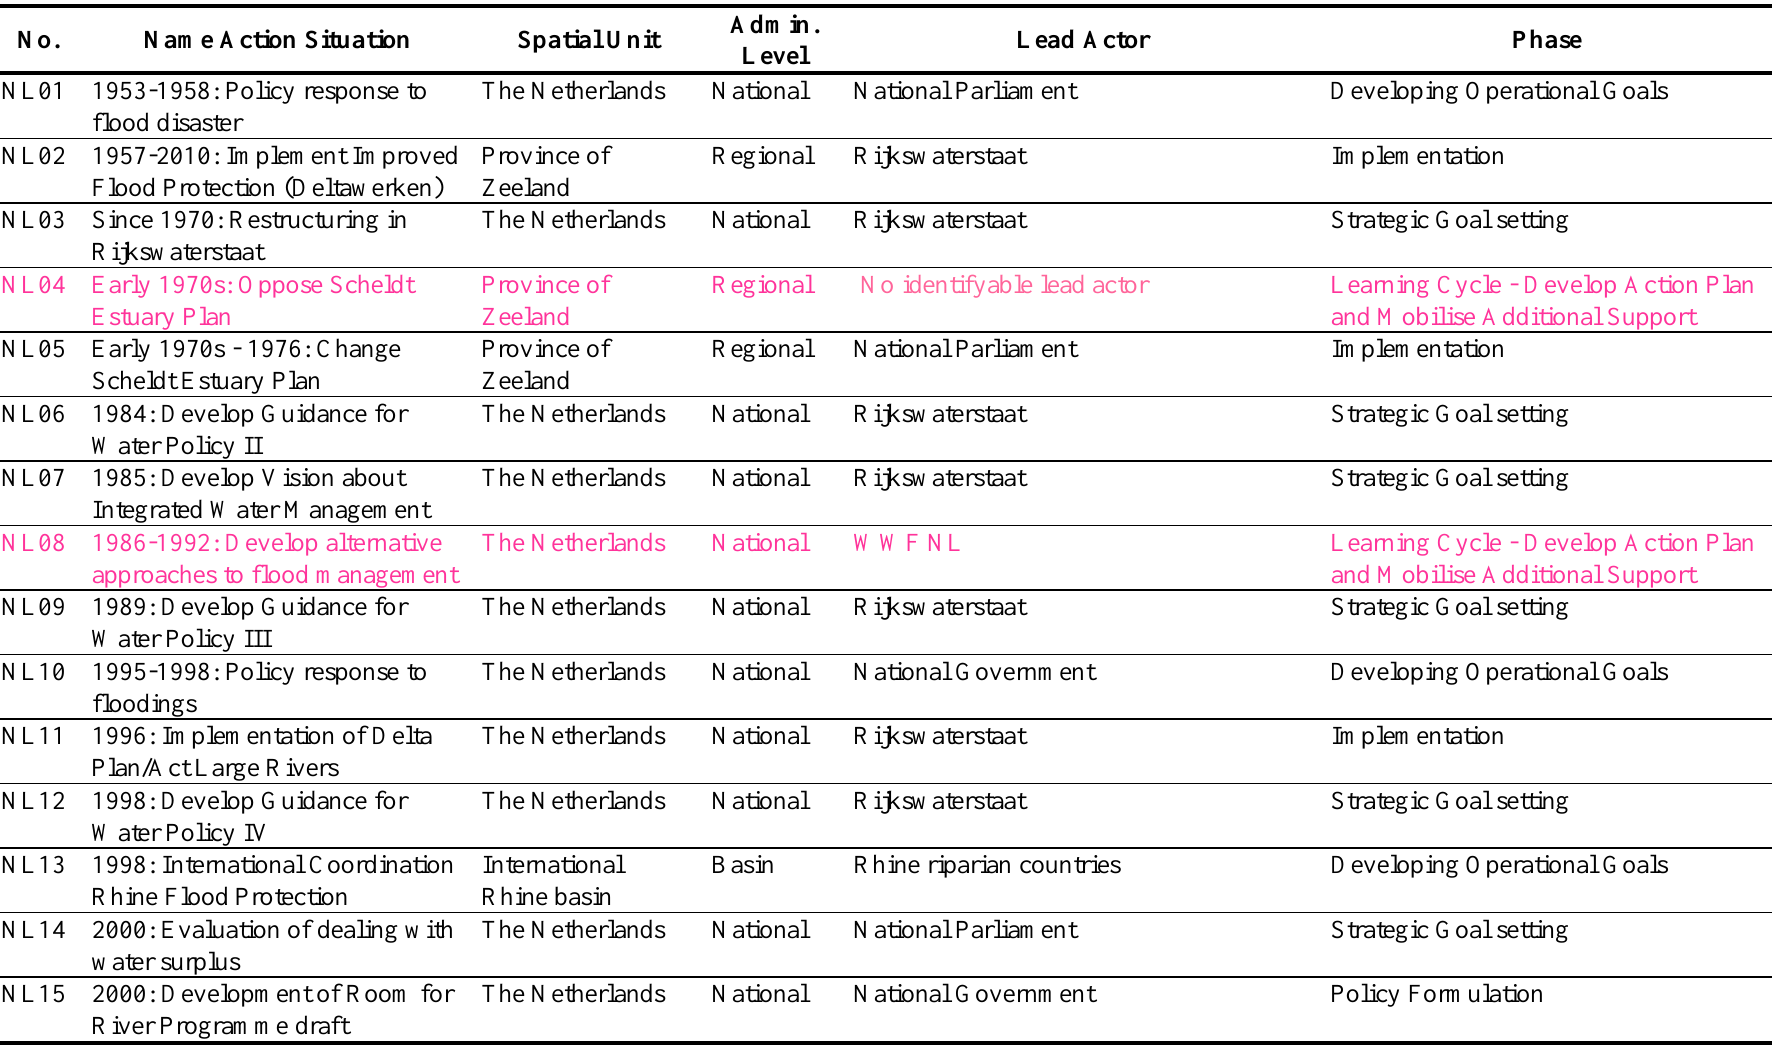
Table A3. Action Situations for Rhine Netherlands (NL, learning ASs in